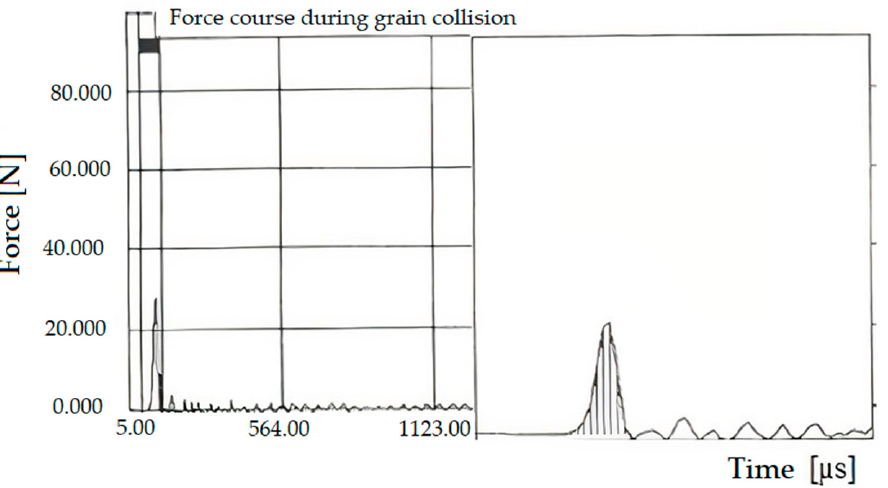
Figure 1. The measuring signal course of the impact force of rye grain of 14% moisture at the speed of 8 m · s − 1 in a force sensor with a 70 kHz resonance frequency [15].